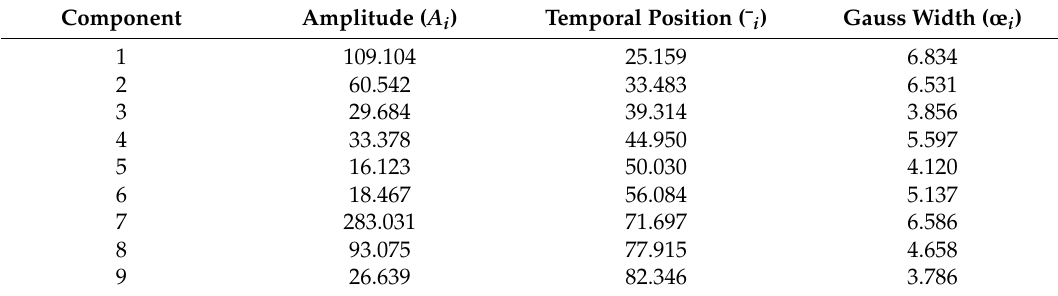
Table 3. Gaussian component parameters.